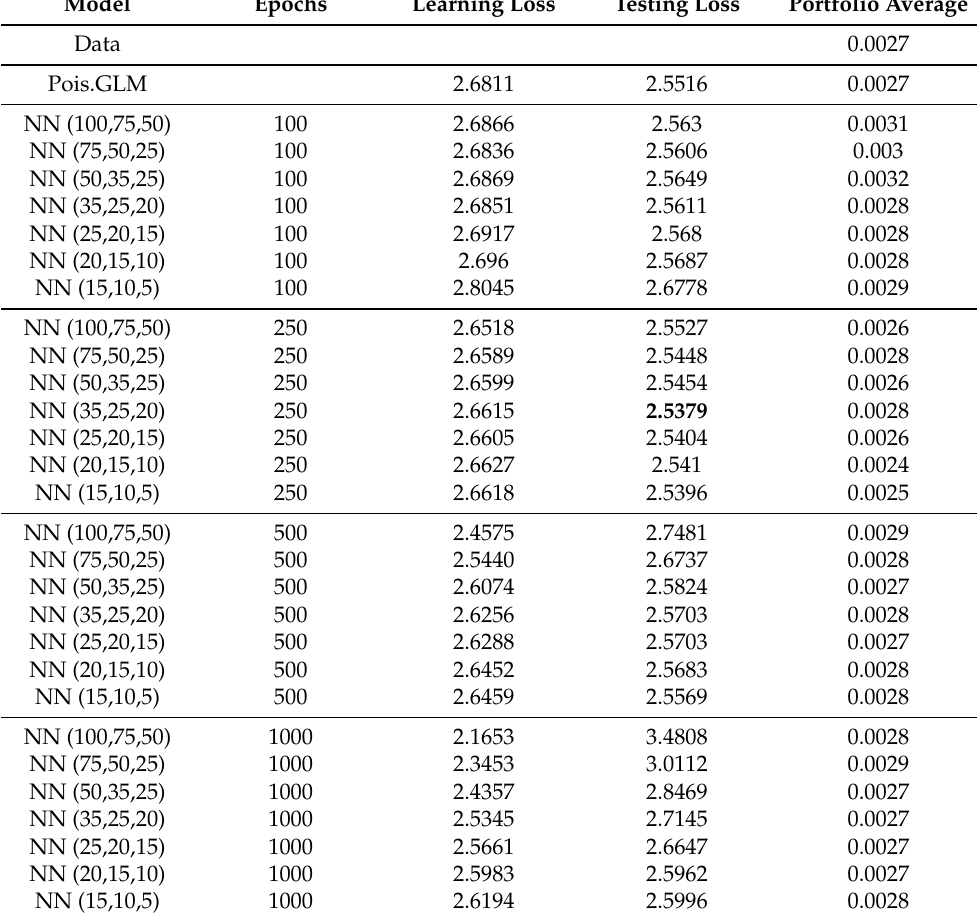
Table A6. The testing loss, learning loss, and portfolio average of the Poisson neural network models with different architectures for different choices of